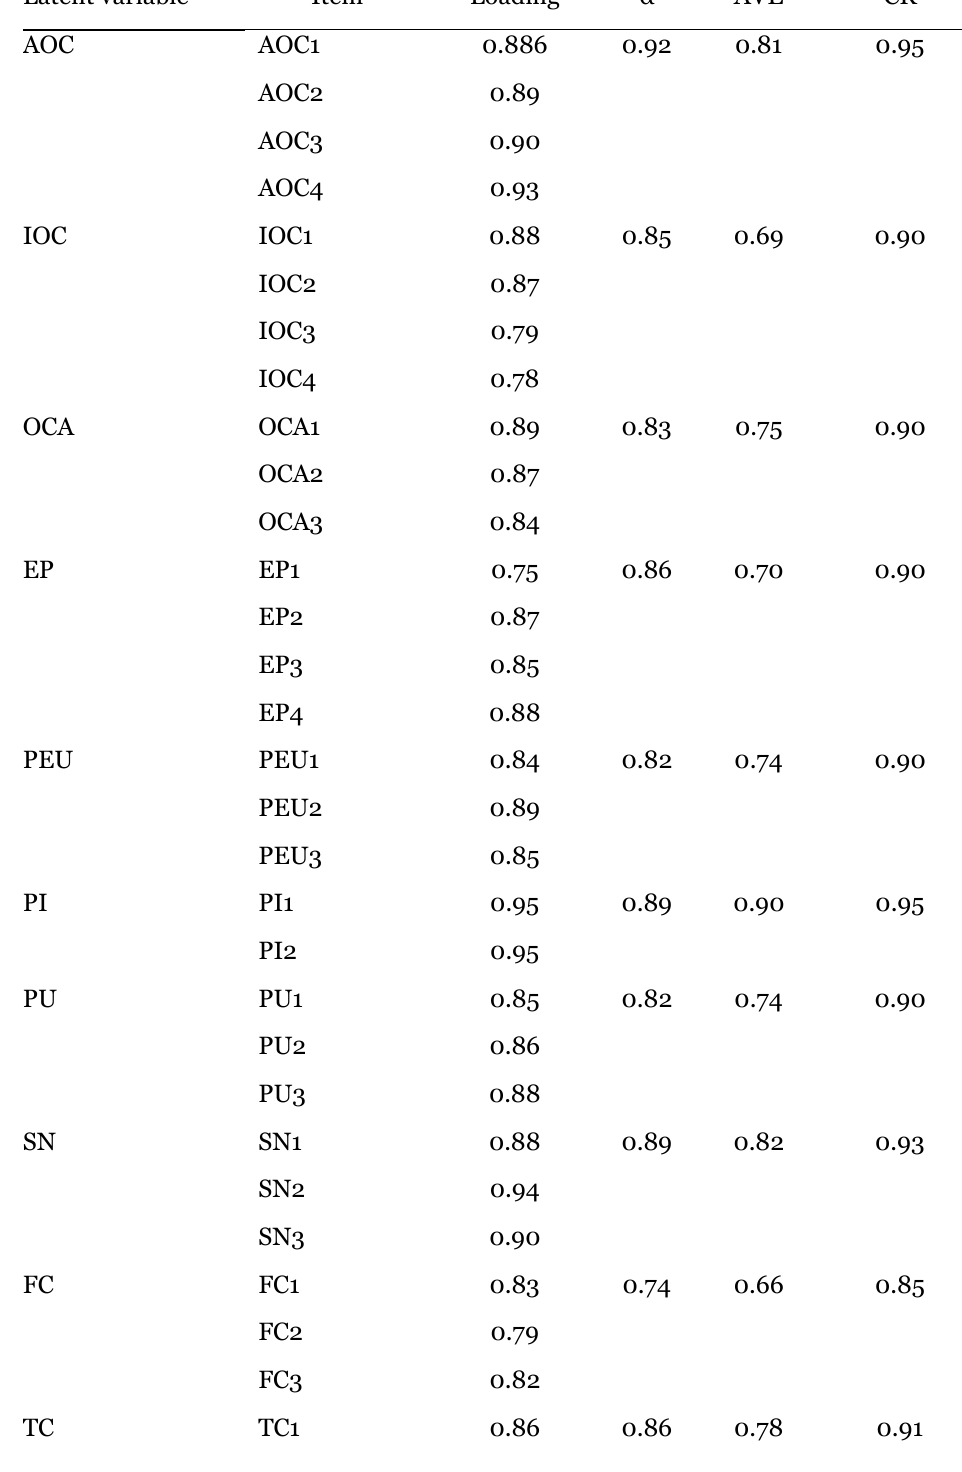
Reliability and Validity